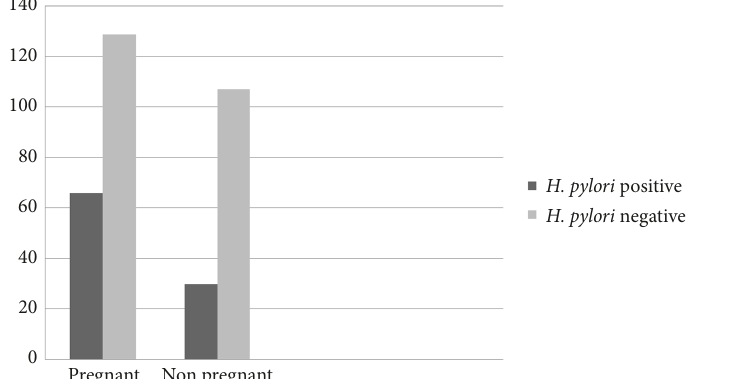
Figure 1: Burden of H. pylori infection among women of child bearing ages in a Woreda 9 HC from April to October 2015, Addis Ababa,